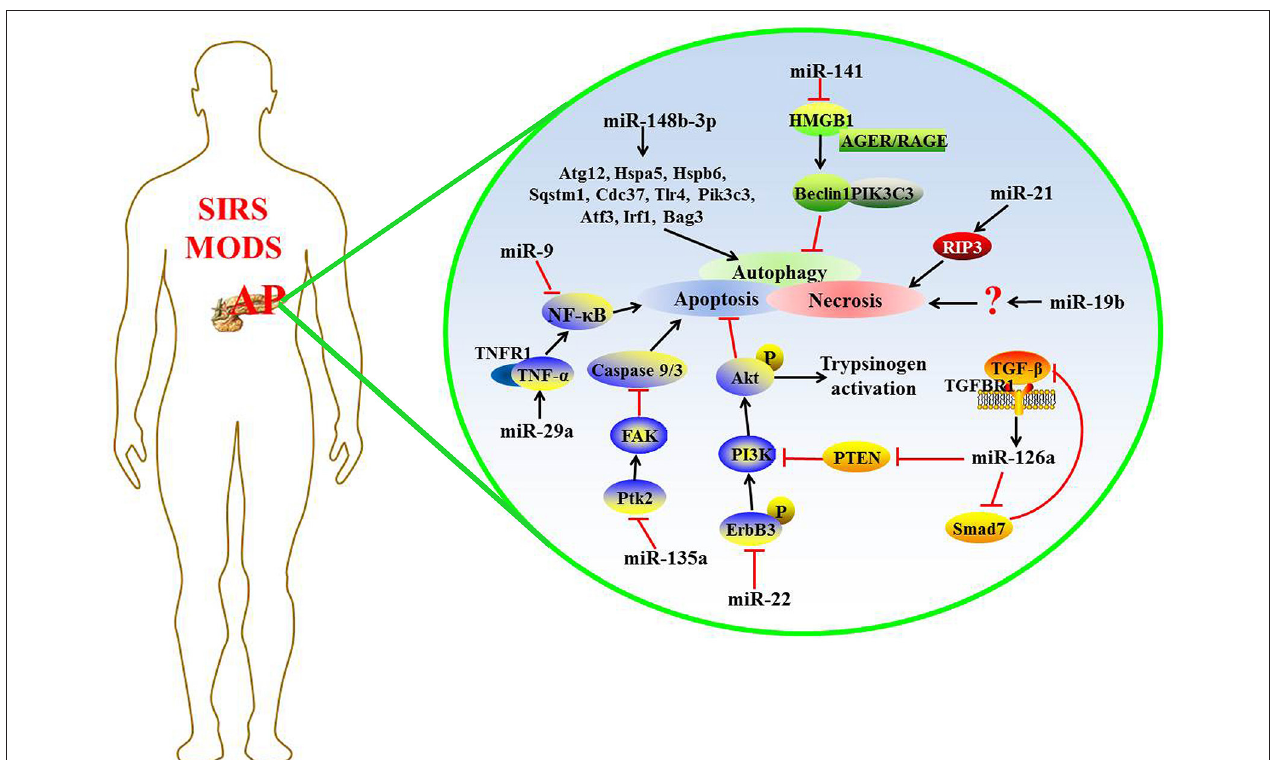
FIGURE 1 | The possible mechanisms of miRNAs regulating target expression in complicated